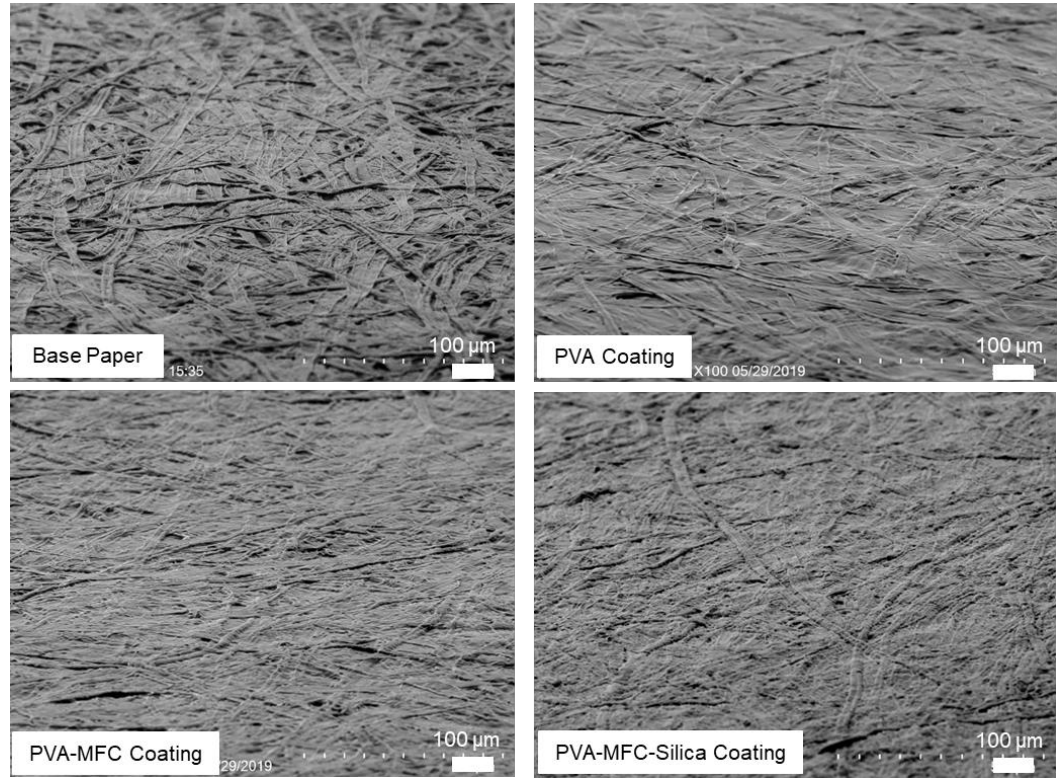
Figure 5. SEM images of the substrate and coating surfaces. Solid white bar denotes 100 µm.